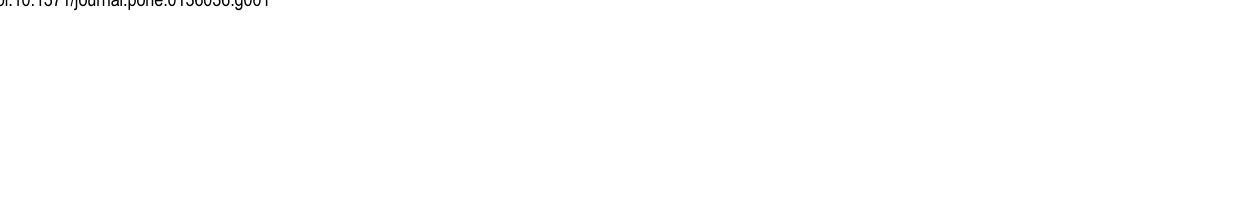
PLOS ONE | DOI:10.1371/journal.pone.0136036 August 18,